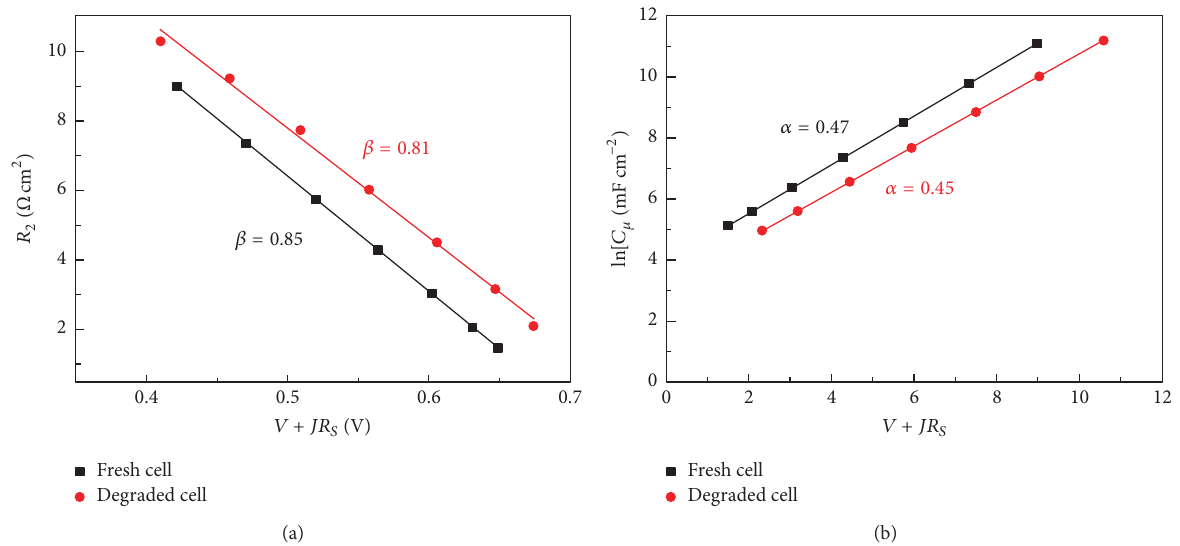
Figure 7: Comparative plot for (a) recombination resistance and (b) chemical capacitance for fresh and degraded DSC, respectively. The line indicates theoretical fit.